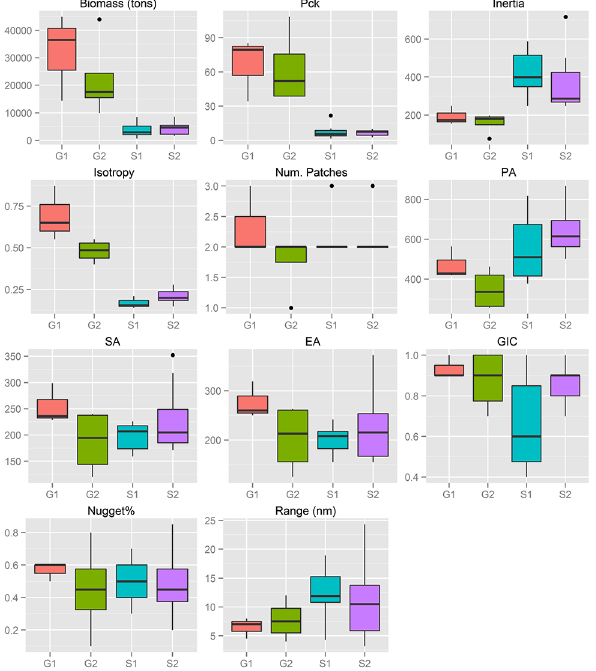
Fig 6. Anchovy: Box-plots of biomass (t), packing density (Pck) and spatial indicator values per sub- area. See Table 1 for descriptions of abbreviations. S1: Adventure Bank sector in Sicilian waters, S2 Maltese Bank sector in Sicilian waters, G1: Thermaikos Gulf, G2: Thracian